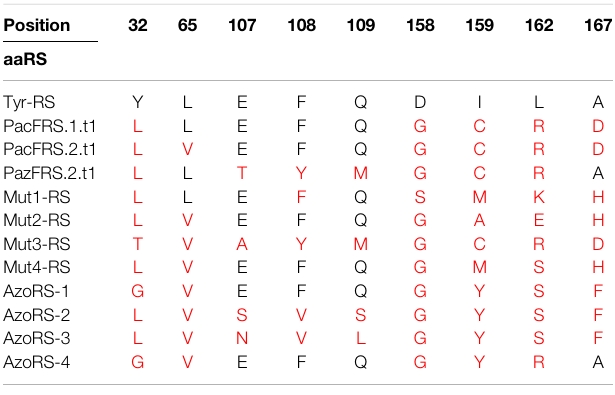
TABLE 1 | Annotations of speci fi c mutations in evolved aaRS variants compared with the WT Methanocaldococcus jannaschii tyrosyl-tRNA synthetase (MjTyrRS) sequence. In addition to the indicated mutations, all mutants harbored the R257G and D286R mutations, which have been shown to improve tRNA